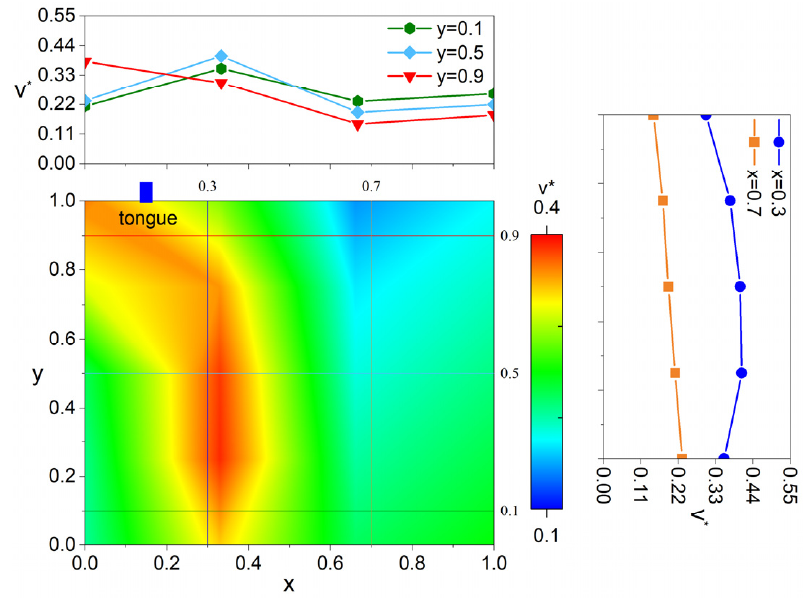
Figure 13. Reconstruction of the flow field at the tongue area under the rated flow rate.